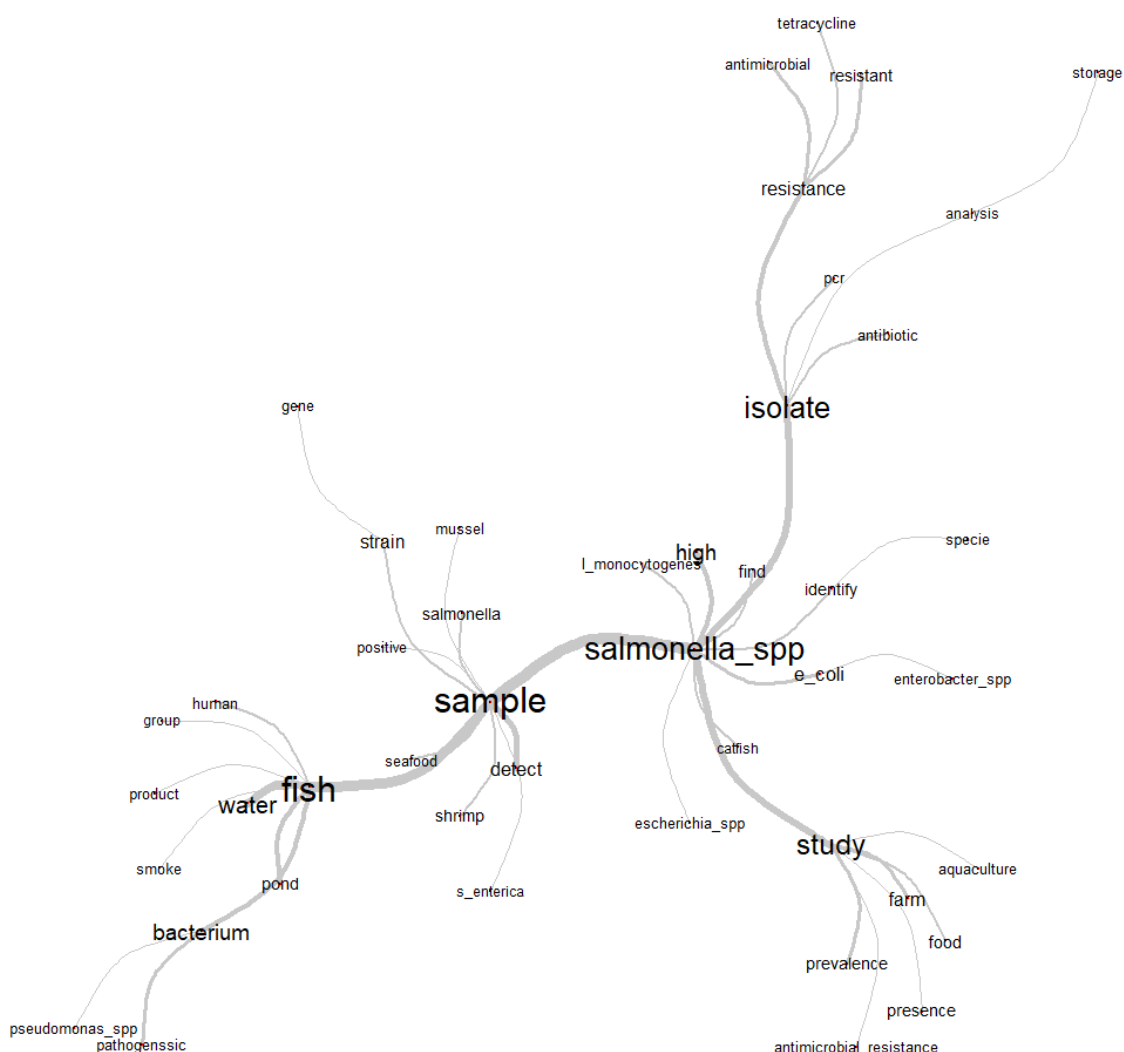
Figure 3. Similarity chart with the relationship of the most used words in the abstracts of the articles selected by the integrative review on microbiological diagnoses of Salmonella spp. in aquaculture between 2000 and